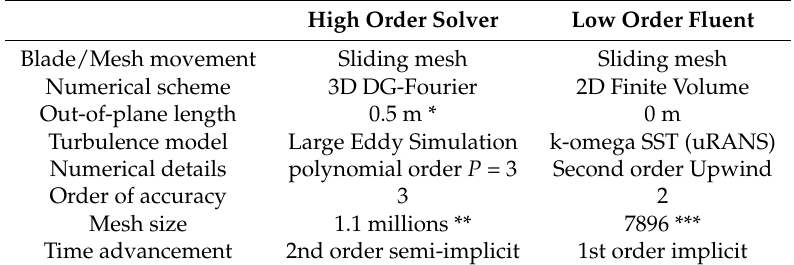
Table 1. Numerical details of the Navier–Stokes computations for a one bladed rotating turbine. The out-of-plane length (marked *) for the high order mesh is discretised using 64 Fourier planes. The high order mesh (marked **) includes the number of elements and the polynomial order P = 3 and 64 Fourier planes for the 3D mesh. For the low order model (marked ***), almost identical results were obtained with a finer mesh of 31,584 elements.